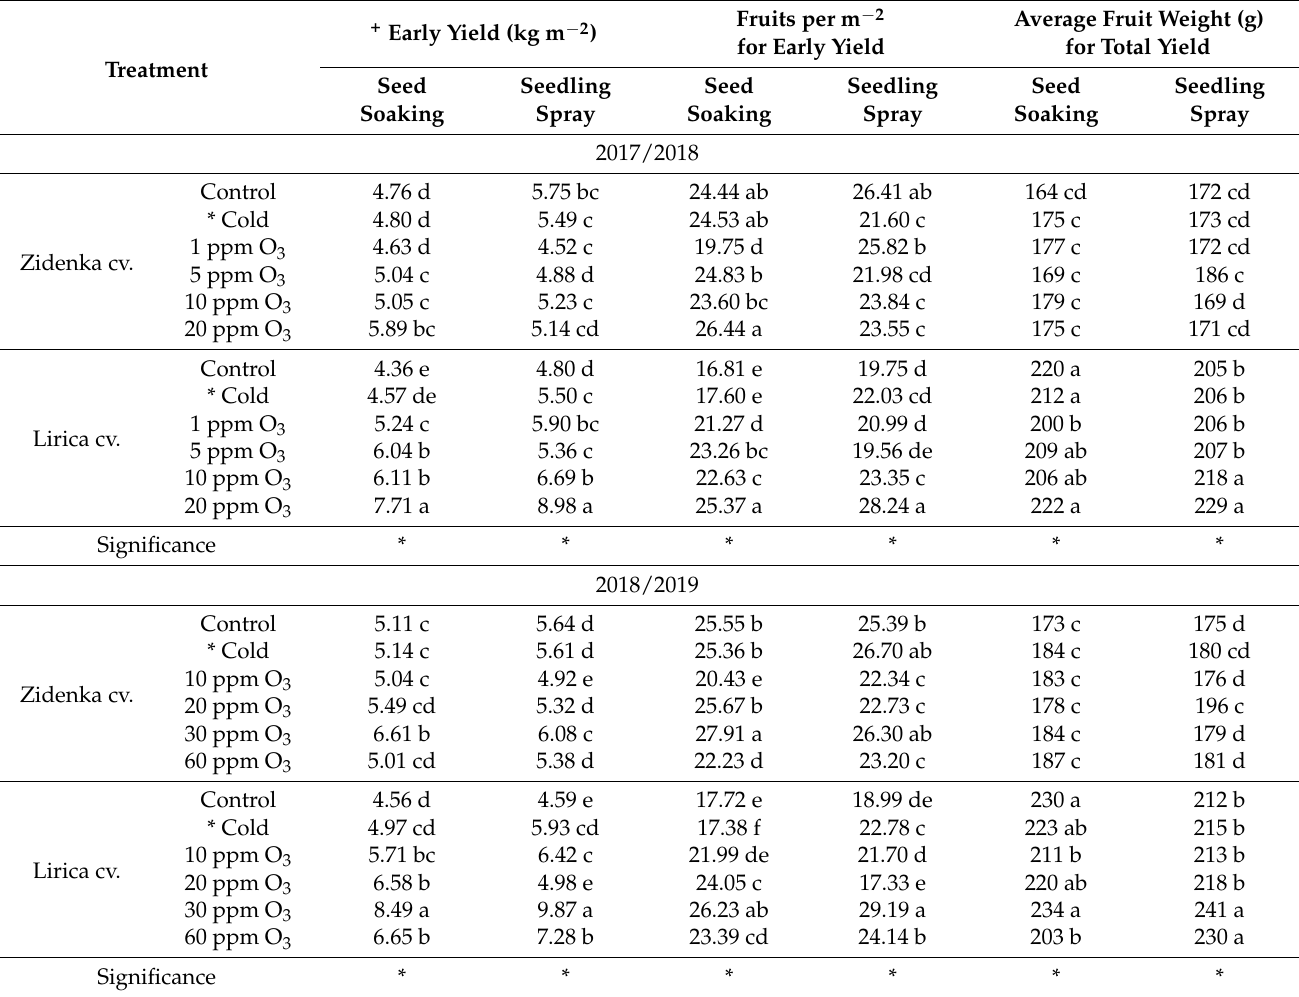
Fruits per m − 2 Average Fruit Weight (g) for Early Yield for Total